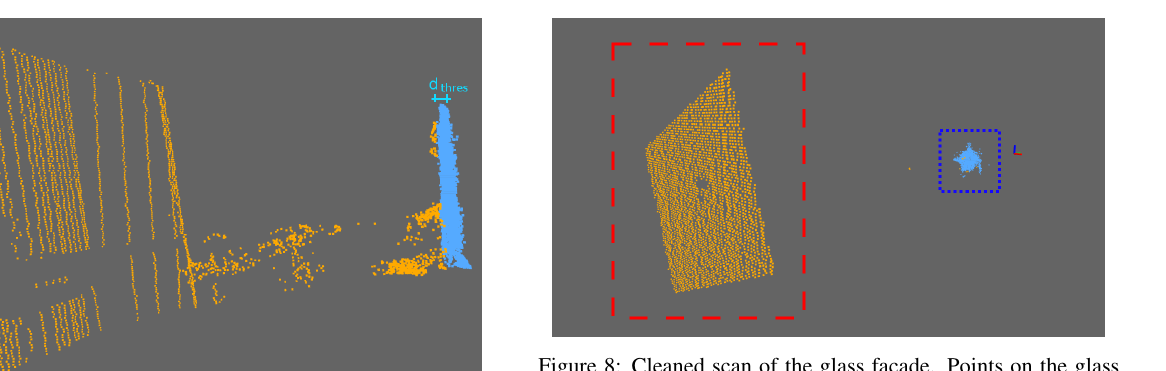
Figure 8: Cleaned scan of the glass facade. Points on the glass facade plane are turquoise, and points behind the glass facade plane are orange.